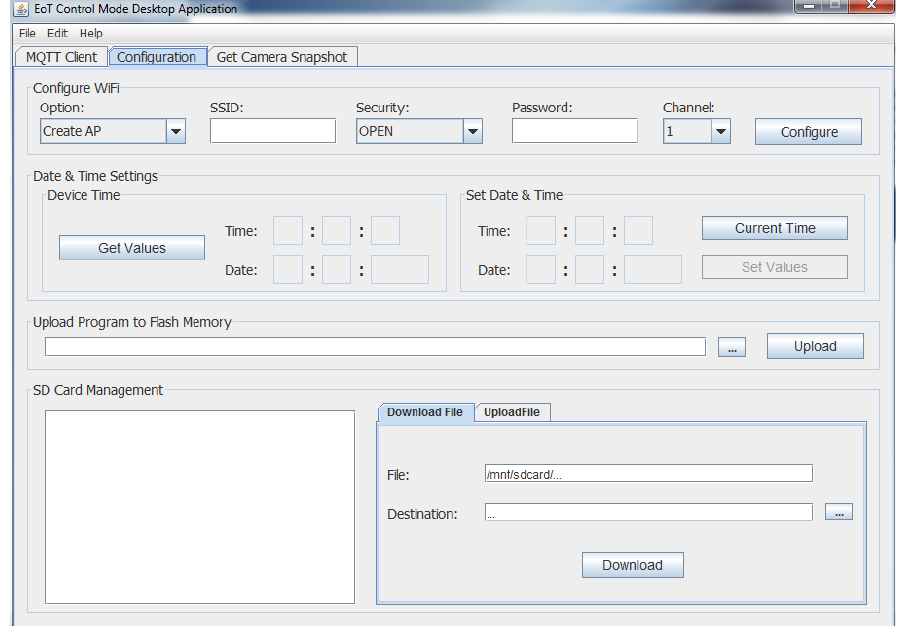
Figure 11. EoT configuration application screenshot (desktop